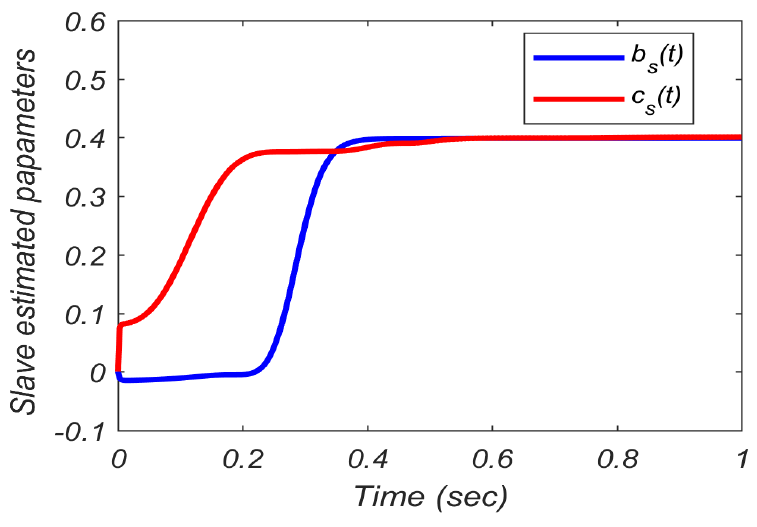
Figure 7. Slave parameter estimation b s and c s .